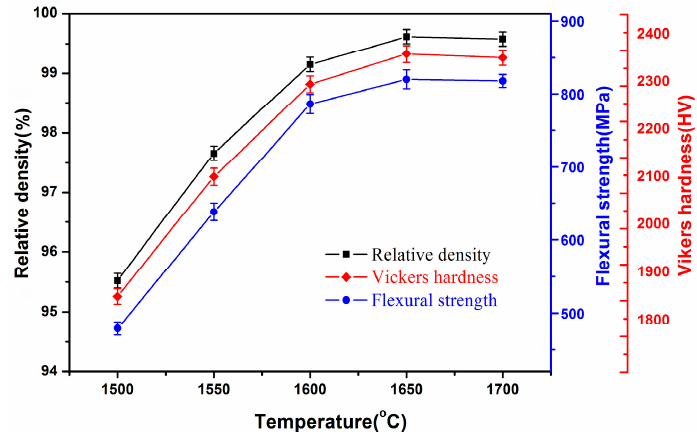
Figure 8. Line chart of mechanical properties of TiB 2 -5 wt. % CoCrFeNiAl HEA composites sintered at different temperatures from 1500 °C to 1700 °C.